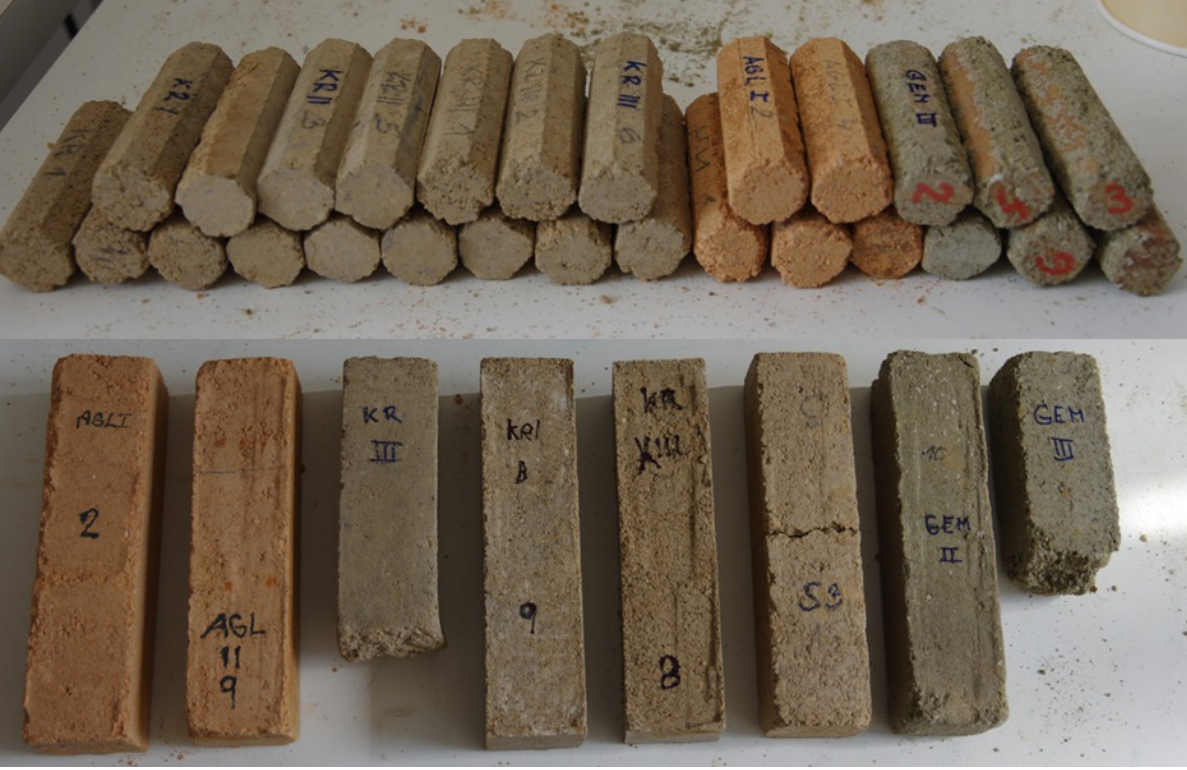
Figure 3. Specimens with di ff erent type of clay as a